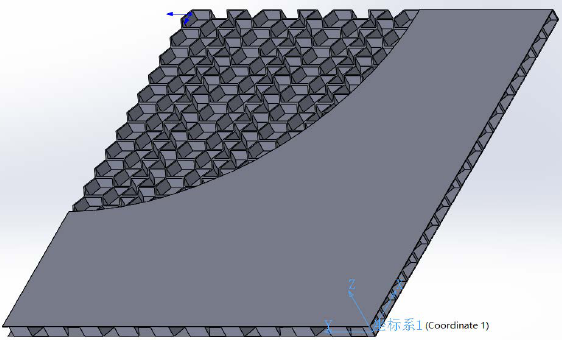
Figure 1. The model of honeycomb sandwich plate with ZPR core.